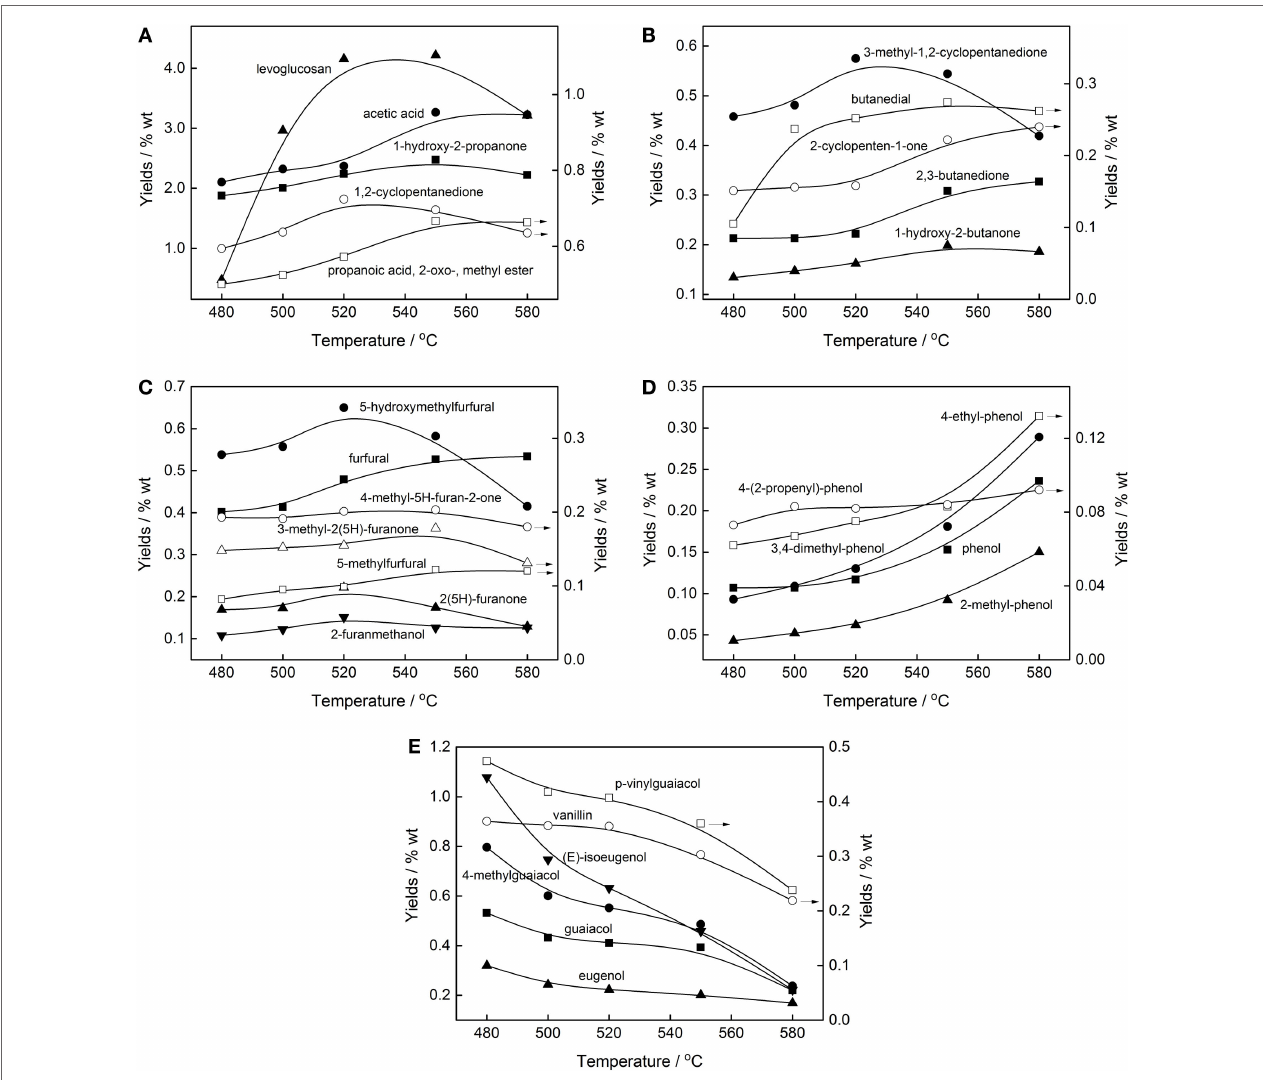
FigUre 5 | influence of temperature on the yield of (a) major carbohydrates, (B) minor carbohydrates, (c) furans, (D) h-phenols, and (e) g-phenols of pine pyrolysis bio-oils